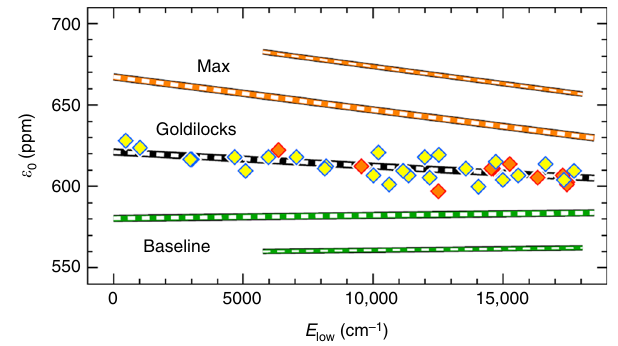
Fig. 3 Elemental oxygen fraction from ATMOS 12 C 16 O data and for three different photospheric models. E low is the energy of the lower rovibrational state for the transition. The “ Goldilocks ” model contains a mid-latitude photospheric temperature perturbation of 43 K that yields equality between the O fraction for Δ v = 2 transitions (yellow diamonds) and Δ v = 1 transitions (orange diamonds), with a linear fi t to the data (black line). The Max (90 K) and Baseline (0 K) models yield less consistent results (small orange and green lines are for Δ v = 1). (Figure after Ayres et al. 12